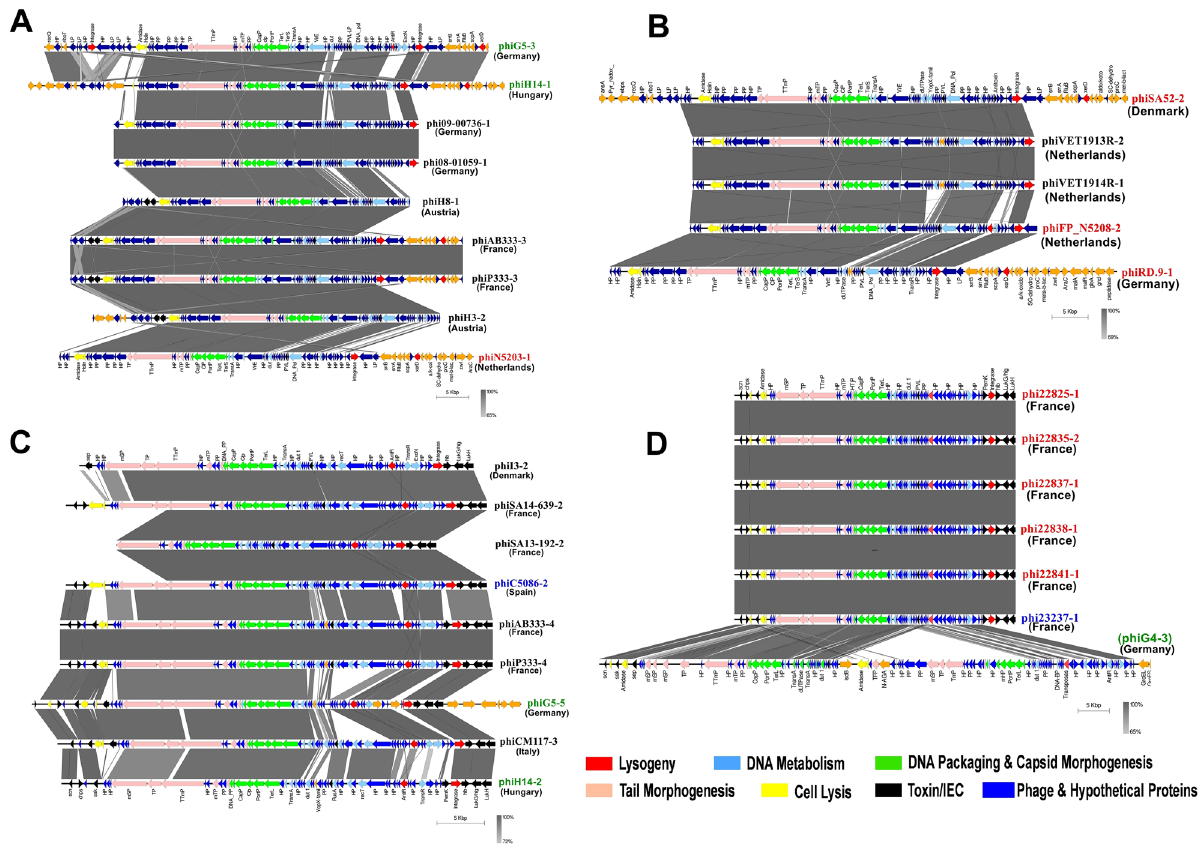
Figure 3. The mosaic architecture of S. aureus prophage genomes. ( A ) Comparison of prophages of clade 1, representing phiG5-3, and phiH14-1 sequenced of our previous study 25 and 7 prophages associated with S. aureus reported from Germany, Austria, France, and Netherlands; ( B ) Comparison of prophages of clade 1, representing prophages of S. aureus associated with Homo sapiens and Bos tourus ; ( C ) Comparison of prophages of clade 3, representing prophages phiG5-5 & phiH14-2 (subclade 3B) sequenced of our previous study and 6 prophages associated with S. aureus reported from Denmark, France, Spain, Germany, Italy, and Hungary; ( D ) Comparison of prophages in clade 3, representing prophages phiG4-3 (subclade 3C) sequenced of our previous study and 6 prophages (subclade 3A) associated with S. aureus spreading in France, Spain, and Germany. Phages and country of origins are indicated on the right (Prophage names labeled in black, red, and blue color indicated prophages associated with Homo sapiens , Bos tourus, and Canis lupus familiaris respectively. And prophage names labeled in green color indicated the prophages extracted from our previous study 25,26 ) and grey shaded regions are homology